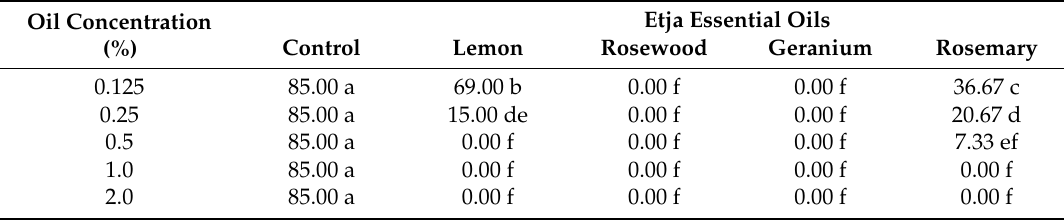
Table 3. The index of linear growth (T) of Fusarium graminearum ZALF 24.